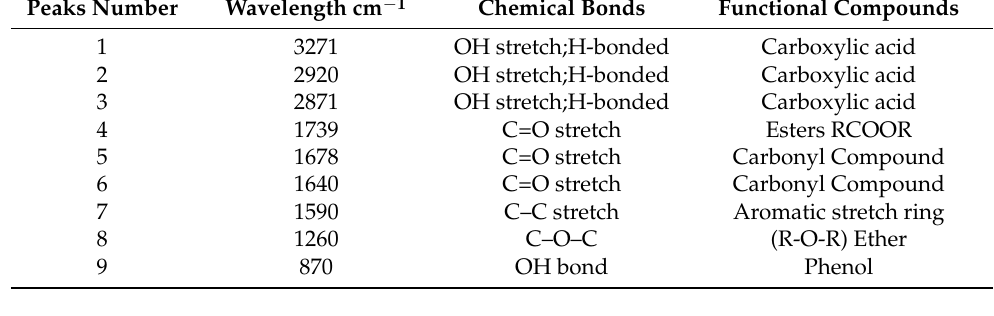
Table 2. The detailed information on the peaks, wavelength, bonds, and functional groups for the FTIR spectrum of GEO.